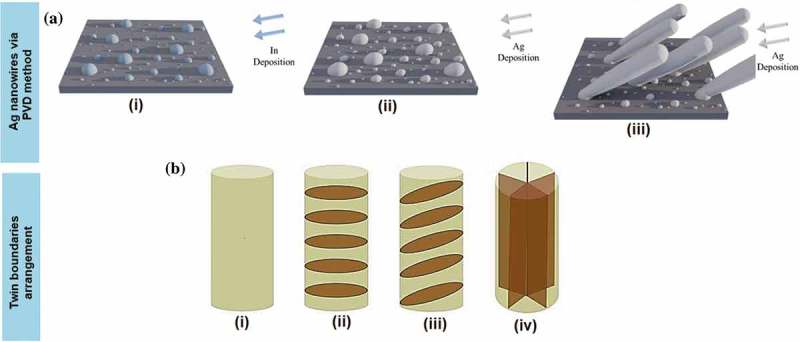
Schematic illustration from (a) on short Ag nanowires growth using PVD method deposited on the Si substrate [185] and (b) on the concept of the twin boundaries arrangement, coloured in brown with (i) single crystal nanowires without twin boundaries, (ii) horizontal, (iii) inclined and (iv) fivefold vertical twin boundaries [200] (adapted with permission from [185] licensed under a Creative Commons Attribution 4.0 International License and [200] copyright (2015) American Chemical Society).